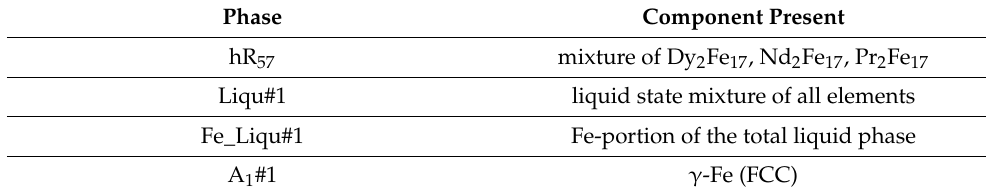
Table 5. List of (theoretical) main phase present near the melting point.